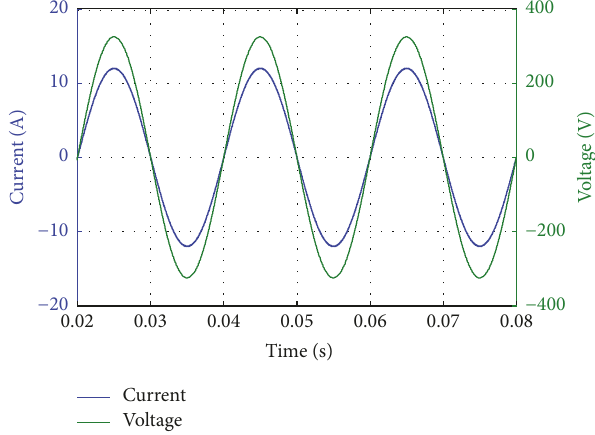
Figure10:Outputvoltageandcurrentofthegridconnectedinverter works at unity power factor.